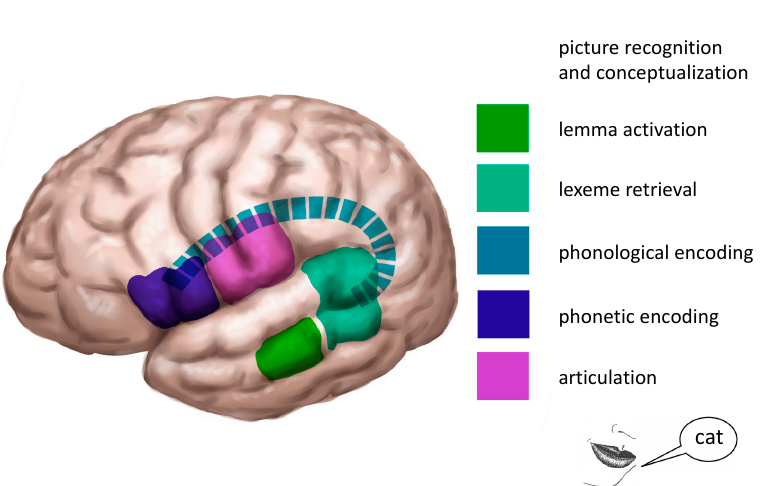
Figure 2. Localization of the naming process in the left hemisphere. Notice that for the preceding processes of ‘picture recognition and conceptualization’, large parts of both hemispheres are activated (not shown). Articulation is also a bilateral process. Based on Indefrey [3]. © Gert van Dijk.